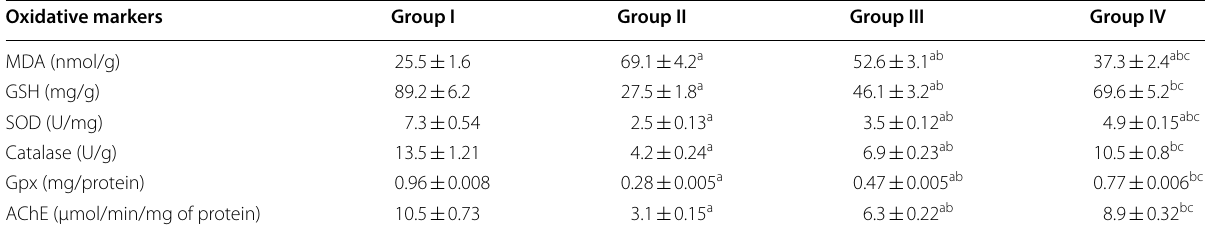
a P < 0.05 vs. group I